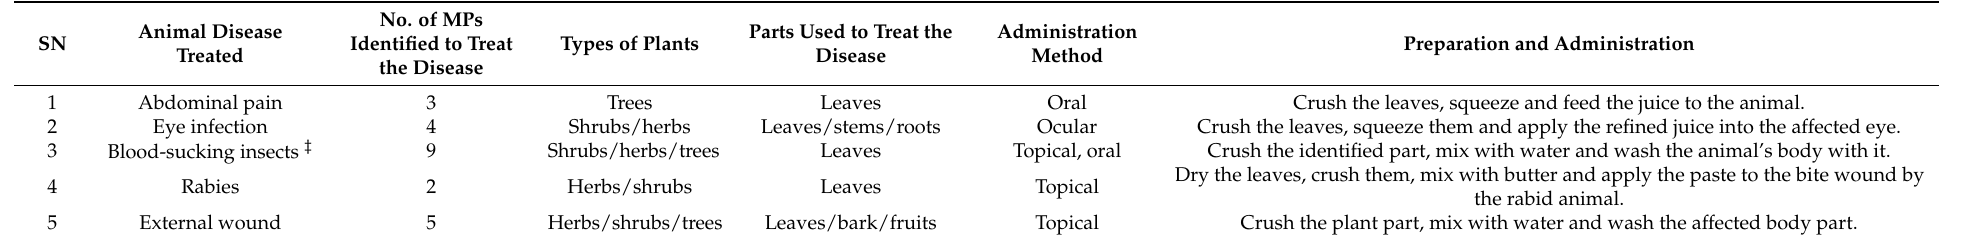
Table 2. Medicinal plants identified and the administration method used to treat animal diseases and manage insect infestations, recorded in the study FDGs.